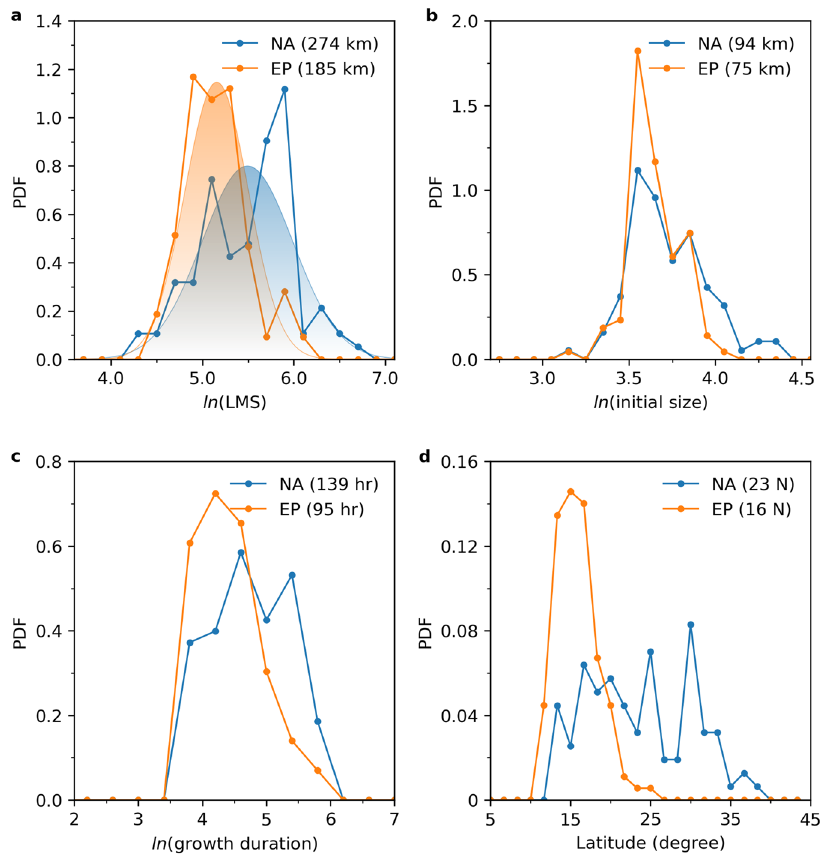
Fig. 4 Distribution of TC growth factors. PDF of log-transformed ( a ) LMS (km), ( b ) initial size (km), ( c ) growth duration (h), and ( d ) mean growth latitude ( ∘ N) for NA and EP TCs. The solid lines and dots are the observed PDFs based on the best track. The bell-shaped shadings in ( a ) denote the fi tted normal distribution. The P value from the lognormal test of LMS is 0.45 in the NA and 0.62 in the EP, respectively, which suggests that the distributions are lognormal. The bin widths are 0.2 in ( a ), 0.2 in ( b ), 0.4 in ( c ), and 2° in ( d ). The mean in each basin is given in the legend.